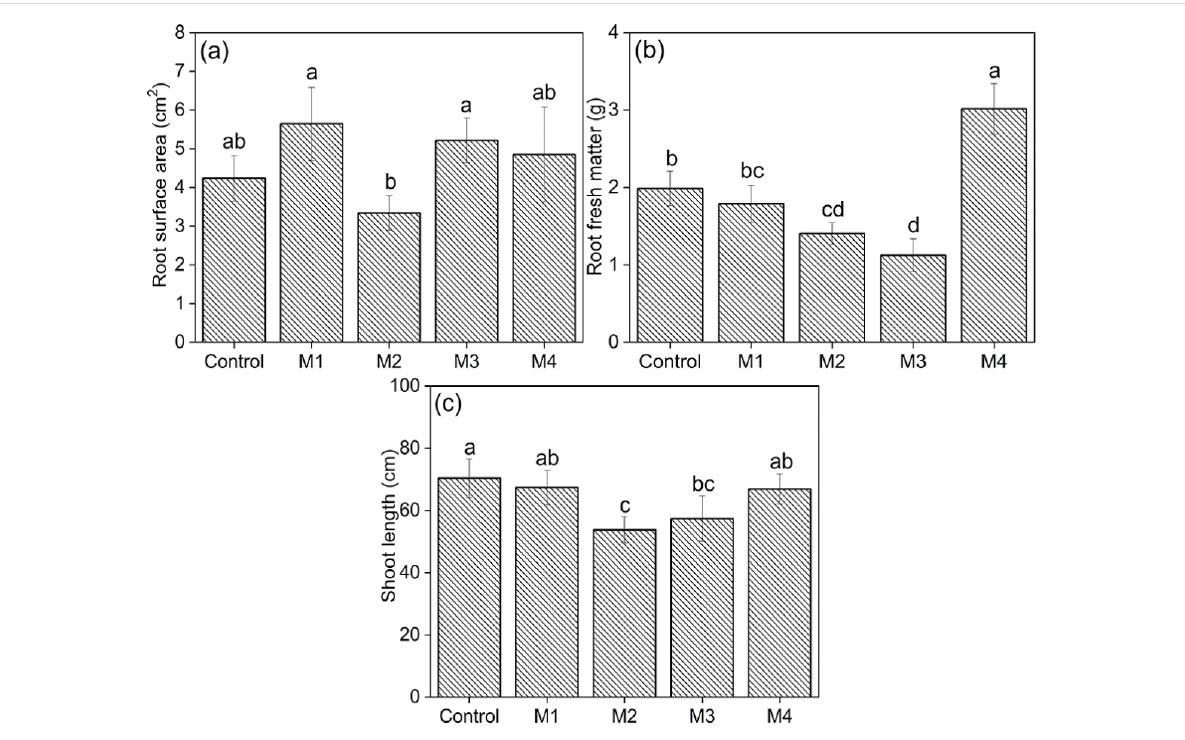
Figure 7: Values of: (a) root surface area, (b) root fresh matter and (c) shoot length for the beans being the seeds coated with: control, M1 = neat algi- nate, M2 = alginate + ZnAl-CO 3 -LDH, M3 = alginate + NAA e M4 = alginate + ZnAl-NAA-LDH. Averages followed by the same letter do not differ from each other by the Tukey test ( p > 0.05).